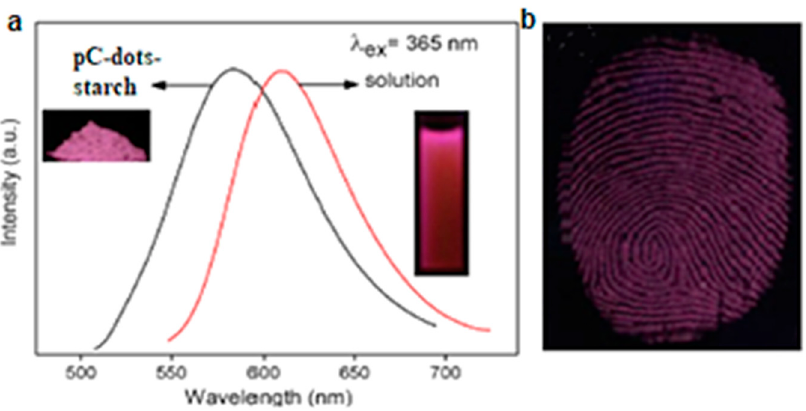
Figure 14. ( a ) PL emission spectra of pC-dots in ethanol and pC-dot starch powder. Inset: pC-dots in ethanol solution ( right ) and pC-dot starch powder ( left ) ( λ ex = 365 nm). ( b ) Image of fingerprints developed with pC-dot starch on glass substrate ( λ ex = 365 nm). Reprinted (adapted) with permission from [83]. Copyright 2021 Elsevier.